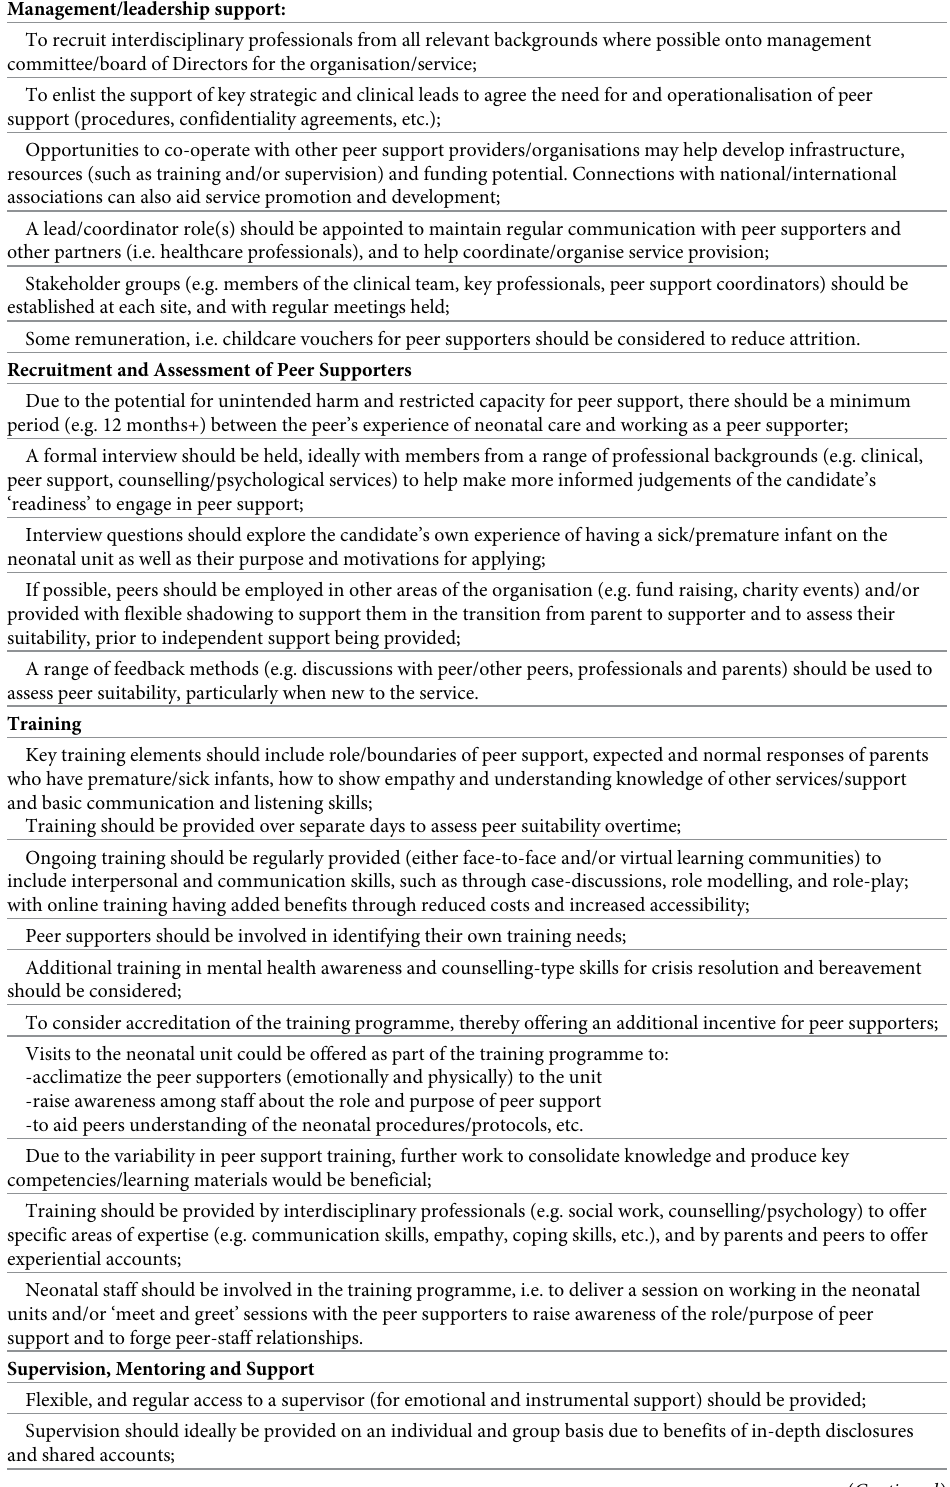
Table 5. Recommendations to inform the organisation and delivery of peer